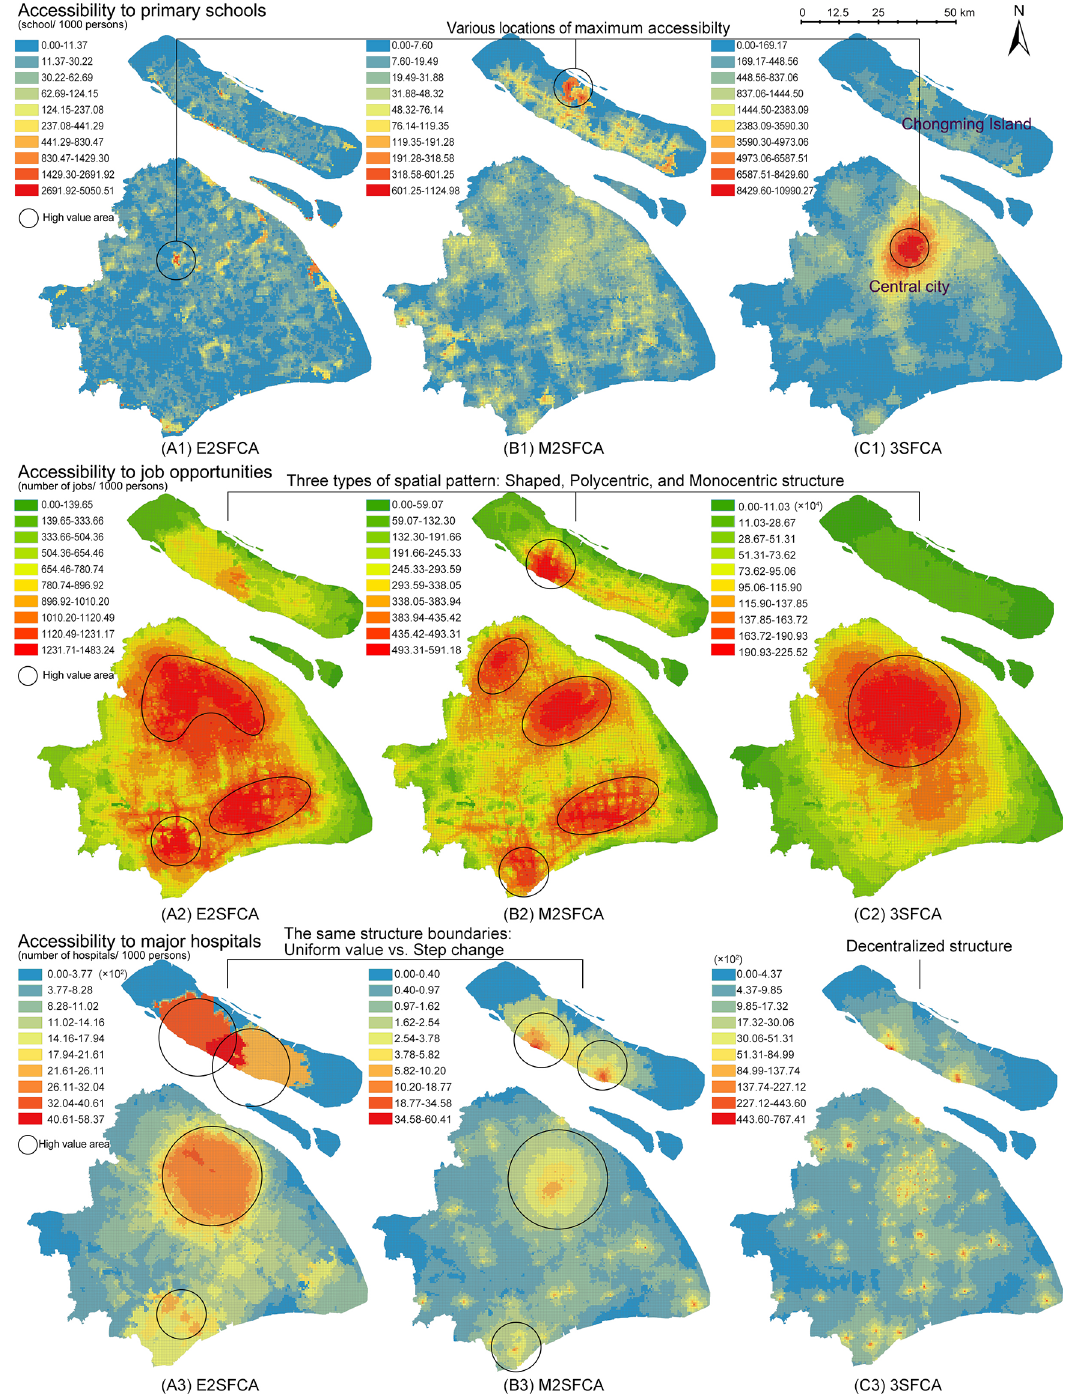
Figure 3. Access as the sum of supply-demand ratios ( A i ). Three floating catchement area (FCA) metrics generate significantly different spatial structures of accessibility. (A) enhanced two-step FCA (E2SFCA), (B) modified two-step FCA (M2SFCA), and (C) three-step FCA